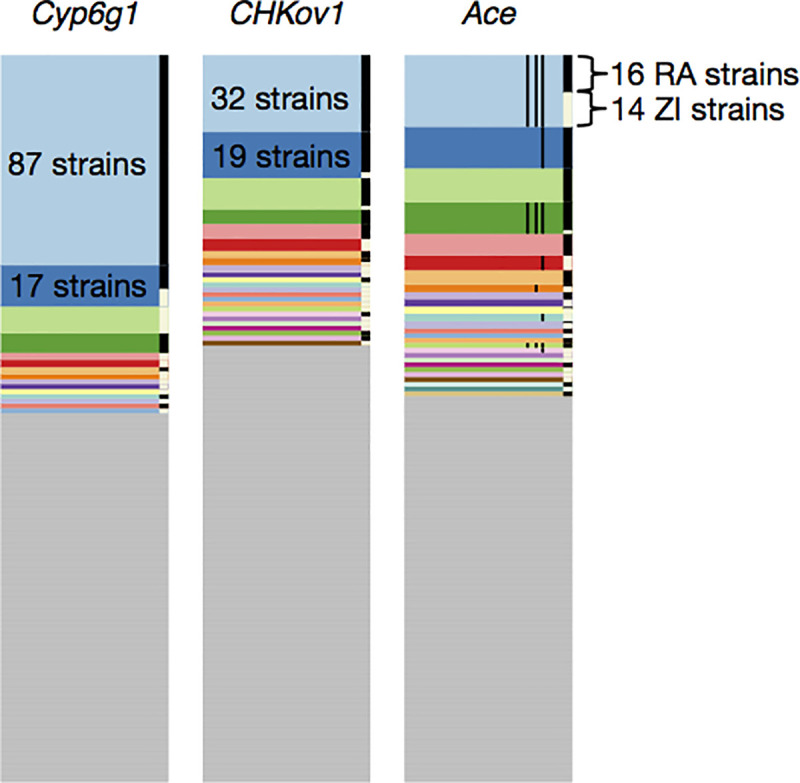
Haplotype frequency spectra at the Cyp6g1, CHKov1, and Ace loci.Recreated from Garud and Petrov 2016 [17]. Haplotype frequency spectra at the three positive controls in a joint dataset, comprised of 300 Raleigh (RA) and Zambian (ZI) strains in 801 SNP windows, centered around the sites of the selective sweeps. 801 SNP windows in the joint data set correspond to slightly smaller analysis window sizes (<10 kb) in terms of base pairs on average than in the Raleigh or Zambian data alone. Each color bar represents a different, unique haplotype, and the height of the bar represents the number of chromosomes sharing the haplotype. The grey bars represent unique, singleton haplotypes in the sample. On the right side of each of the frequency spectra are black and white bars, indicating which strains are from RA and ZI, respectively. At all three positive controls, common haplotypes are shared across the two populations. The thin vertical black lines shown in the haplotype spectrum for Ace correspond to the presence of three adaptive mutations that confer pesticide resistance.